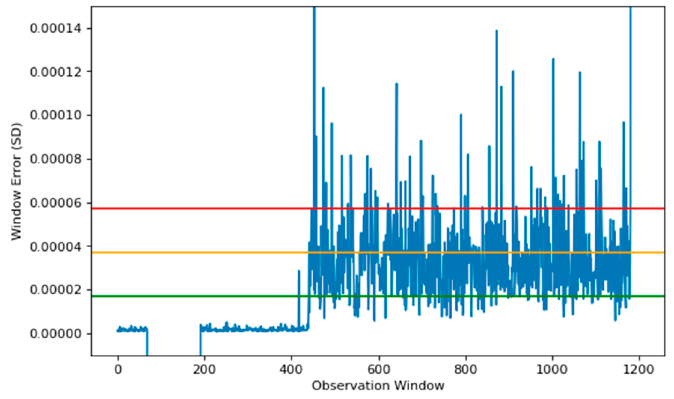
Figure 8. Reconstruction plot using SAE model, using a data window of 500, on known fault data, using MSE as the indicator. The lines denote the previous threshold based upon the healthy data used to train the model. Here the observation window of ~440 indicates a predictive time of 70 min before the initial breakdown